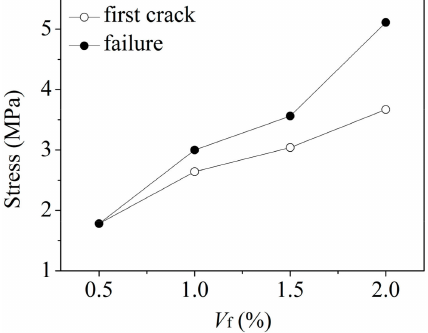
Figure 11. Influence of V f on tensile stress.